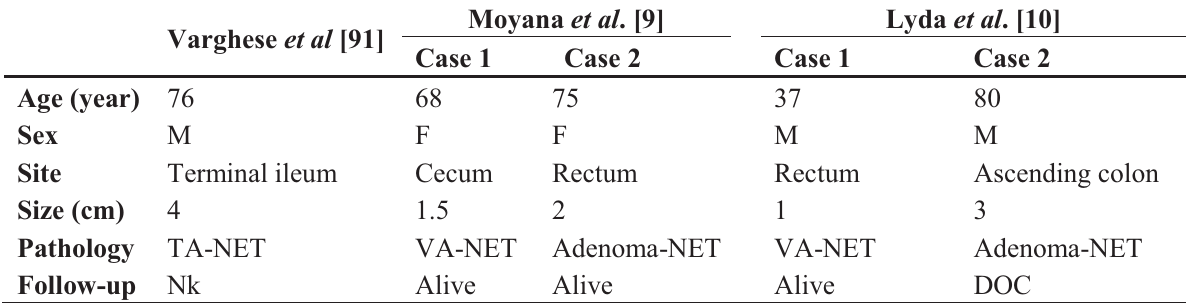
Table 4. Clinico-pathologic features of adenoma-neuroendocrine tumors. Varghese et al